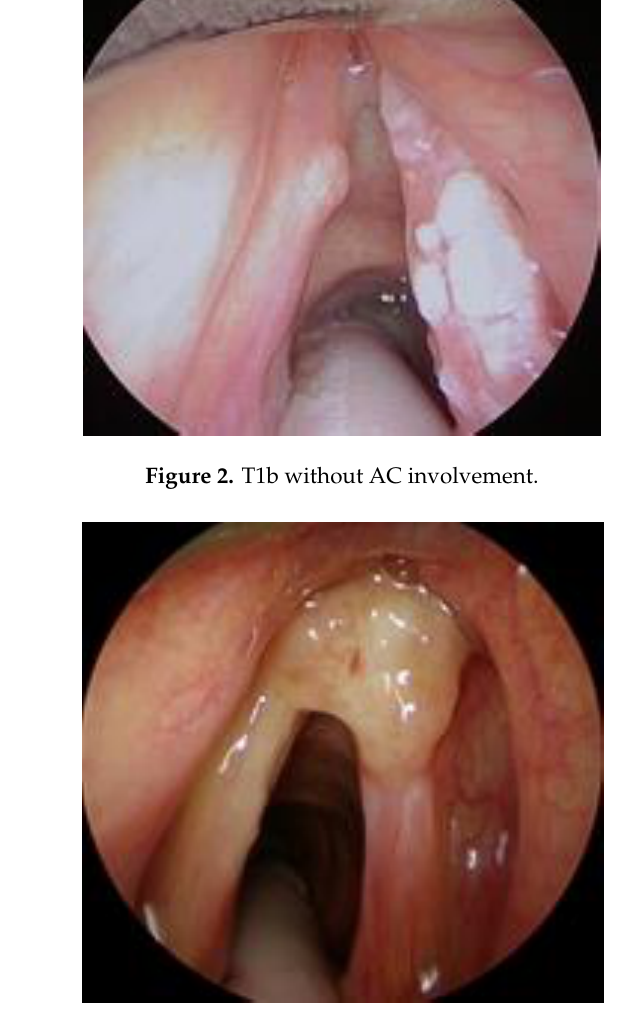
Figure 3. T1b with AC involvement.